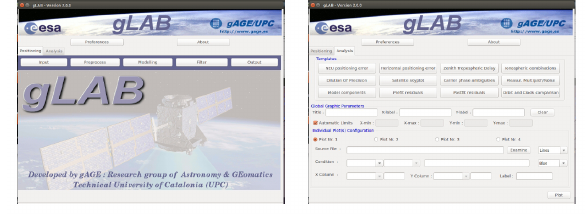
Figure 3: gLAB Interface